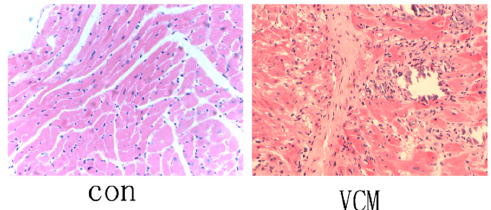
Figure 1. H&E stain of the left ventricle of mice from the control and viral myocarditis (VMC) groups (original magnification 9100). Many macrophages and lymphocytes had infiltrated the myocardium on day 7 after infection.